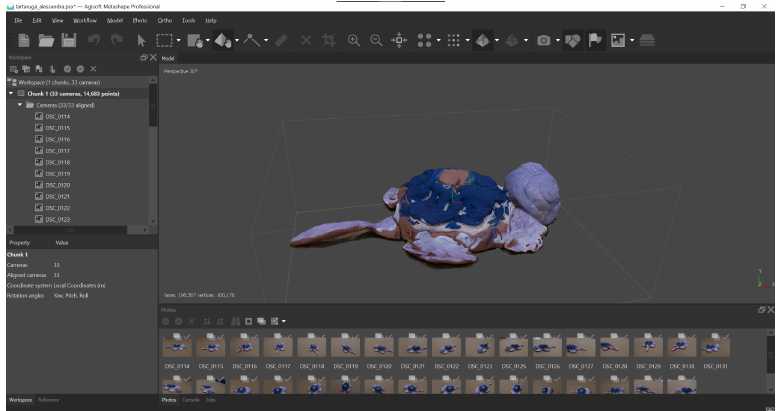
Figure 3. Creation of the 3D mesh of a clay sculpture in Agisoft